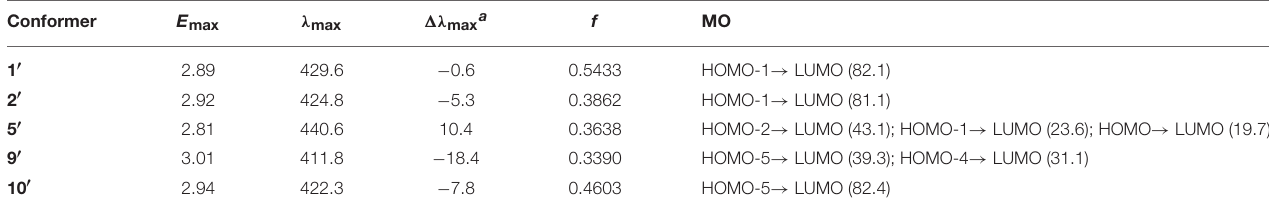
binding Gibbs free energies ( 11 G ) and Boltzmann weights ( BW ) for selected conformers of the complex of oenin/deprotonated syringic acid (energies in kcal/mol, entropies in J/(K • mol) and BW in %).